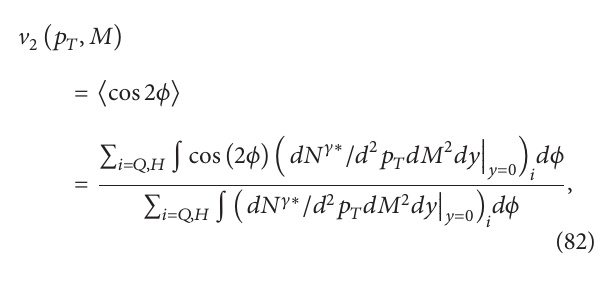
− 𝑅 2 as a function of ⟨𝑀⟩ [14, out side